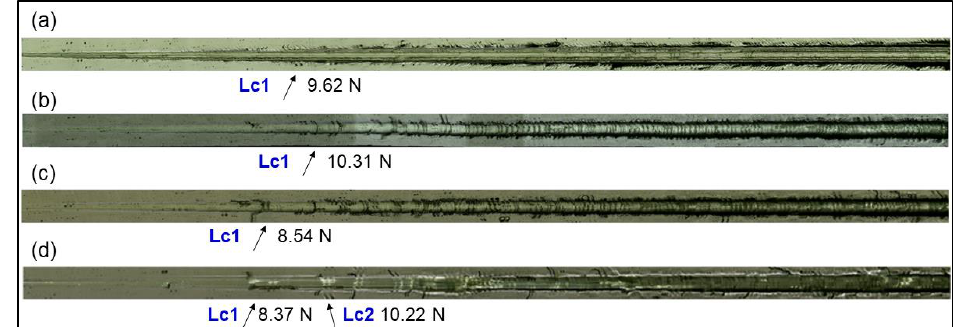
Figure 12. OM pictures of the scratch test for TiAlN coatings deposited under the nitrogen flow rates of 0 sccm ( a ), 40 sccm ( b ), 50 sccm ( c ) and 60 sccm ( d ).